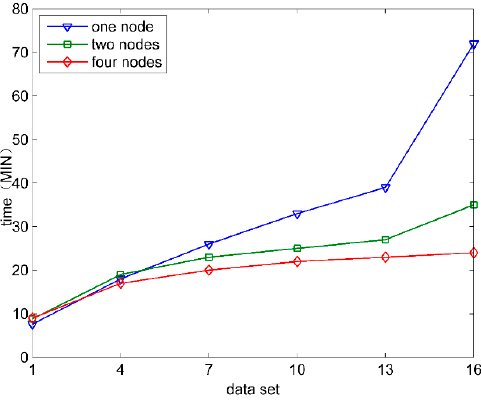
Figure 6. The parallel computing effectiveness.